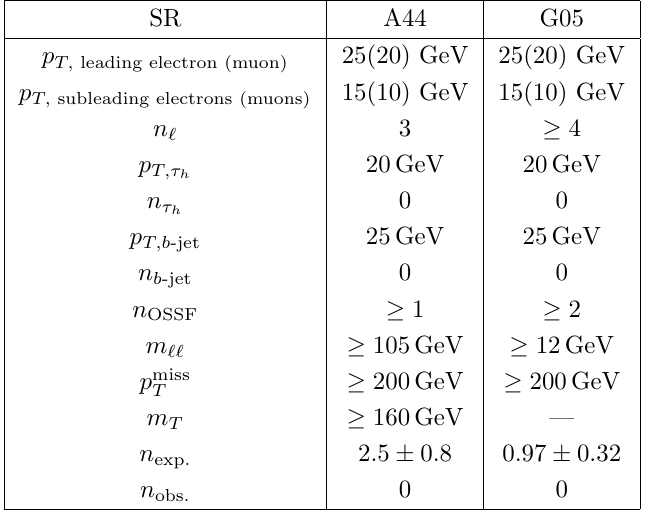
Table 4 . Relevant multilepton signal regions, taken from ref. [42]. If the leading lepton is muon, while the rest of the leptons are electrons, the leading muon p T has to be greater than 25 GeV for both of signal